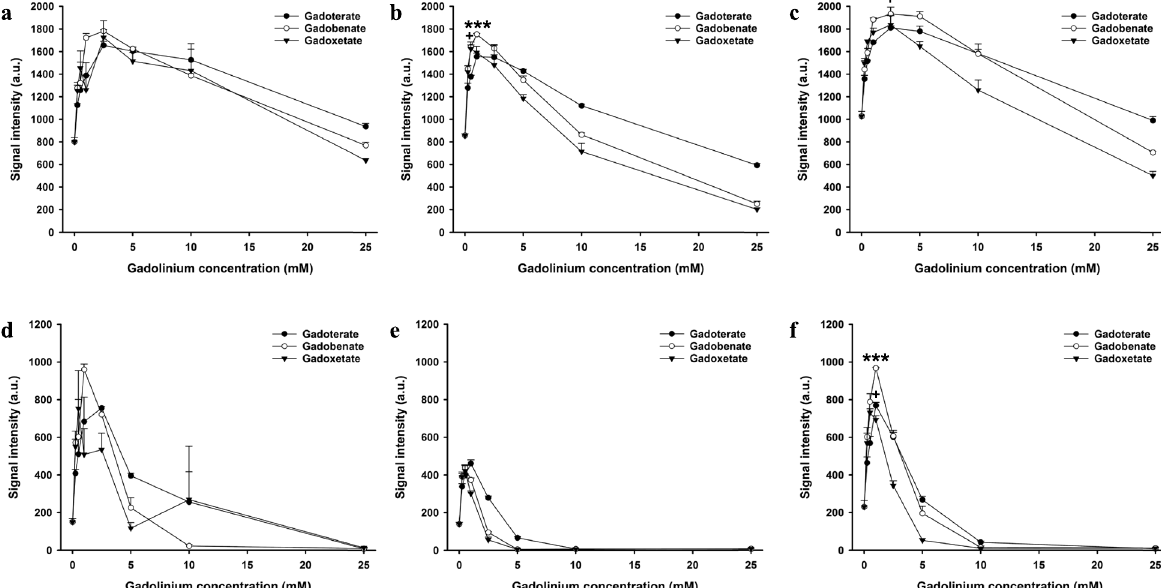
Fig. 3 Signal intensities of gadoterate, gadobenate, and gadoxetate in saline and biological fluids on three‑dimensional multiecho fast field‑echo (3D mFFE) and multiecho gradient‑ and spin‑echo (mGraSE) sequences. Signal intensities of gadoterate, gadobenate, and gadoxetate at different concentrations in saline ( a ), blood ( b ), and bile ( c ) on 3D‑mFFE sequence. Signal intensities of gadoterate, gadobenate, and gadoxetate at different concentrations in saline ( d ), blood ( e ), and bile ( f ) on mGraSE sequence. * significantly higher maximum signal intensity of the contrast agent than = both other contrast agents; significantly higher maximum signal intensity than the contrast agent with the lowest maximum signal intensity. * + = or p < 0.050, ** or p < 0.010; *** or p < + = + + = + + + =